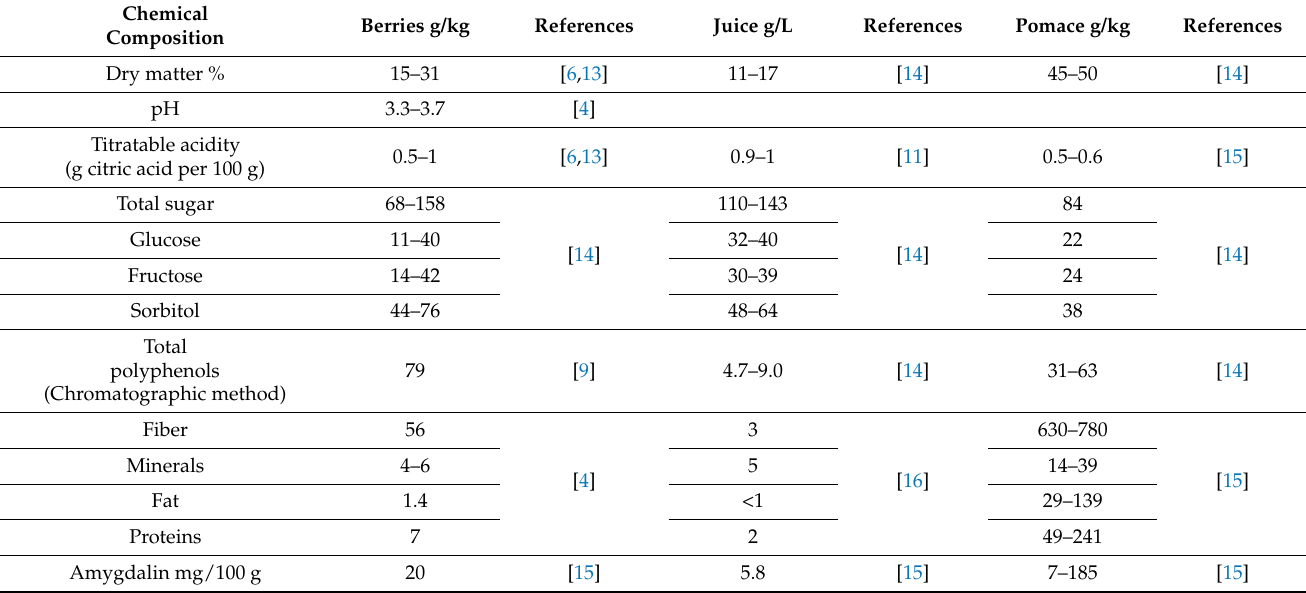
Table 1. Chemical composition of chokeberry, juice and pomace.